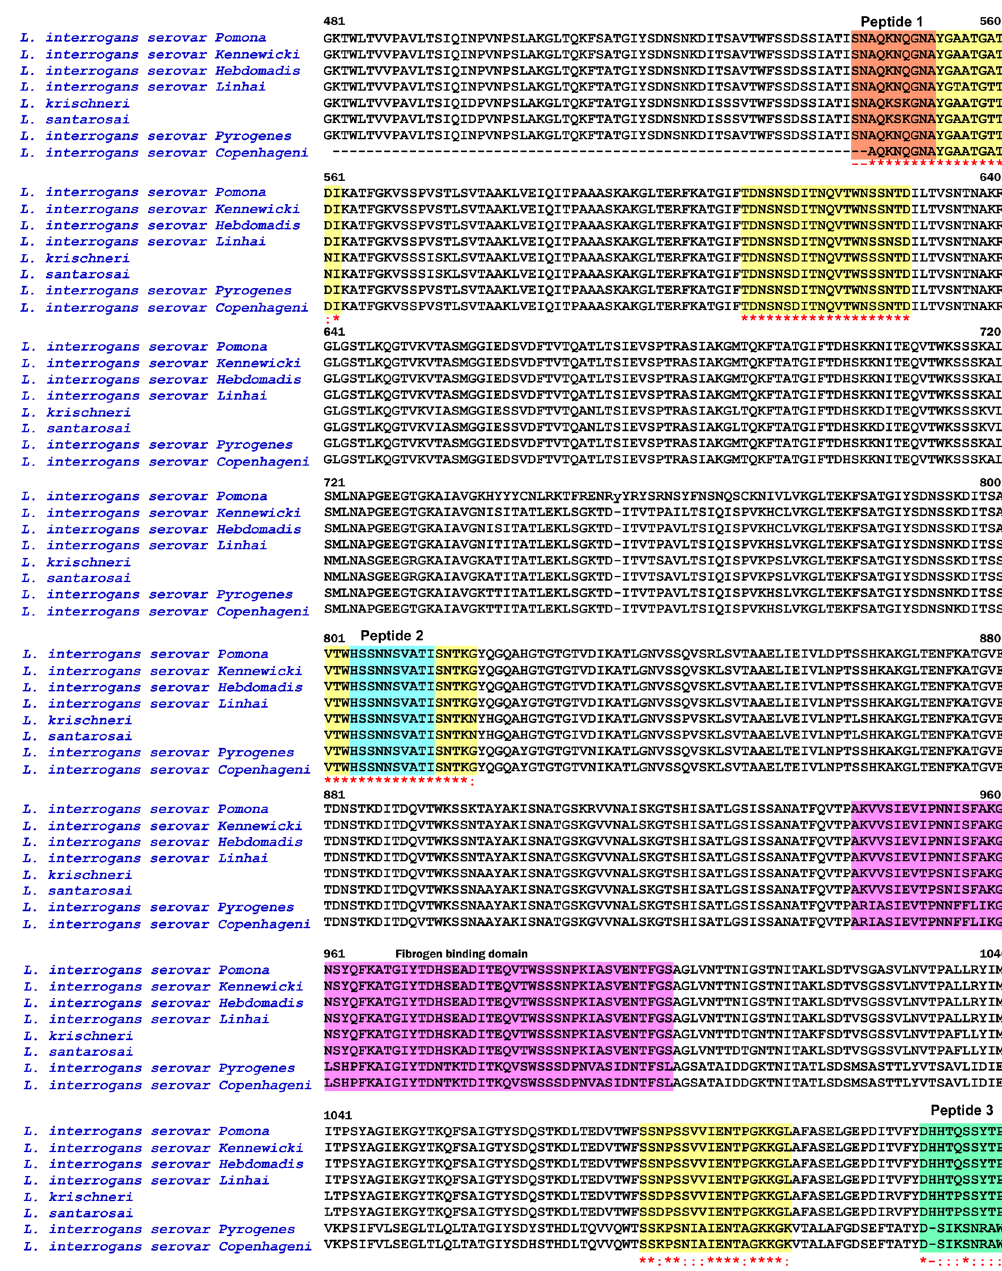
human and animal leptospirosis is detection of specific serum antibody by MAT, and ELISA. These serological methods depend on the presence of circulating antibody and have variable sensitivities and specificities. And